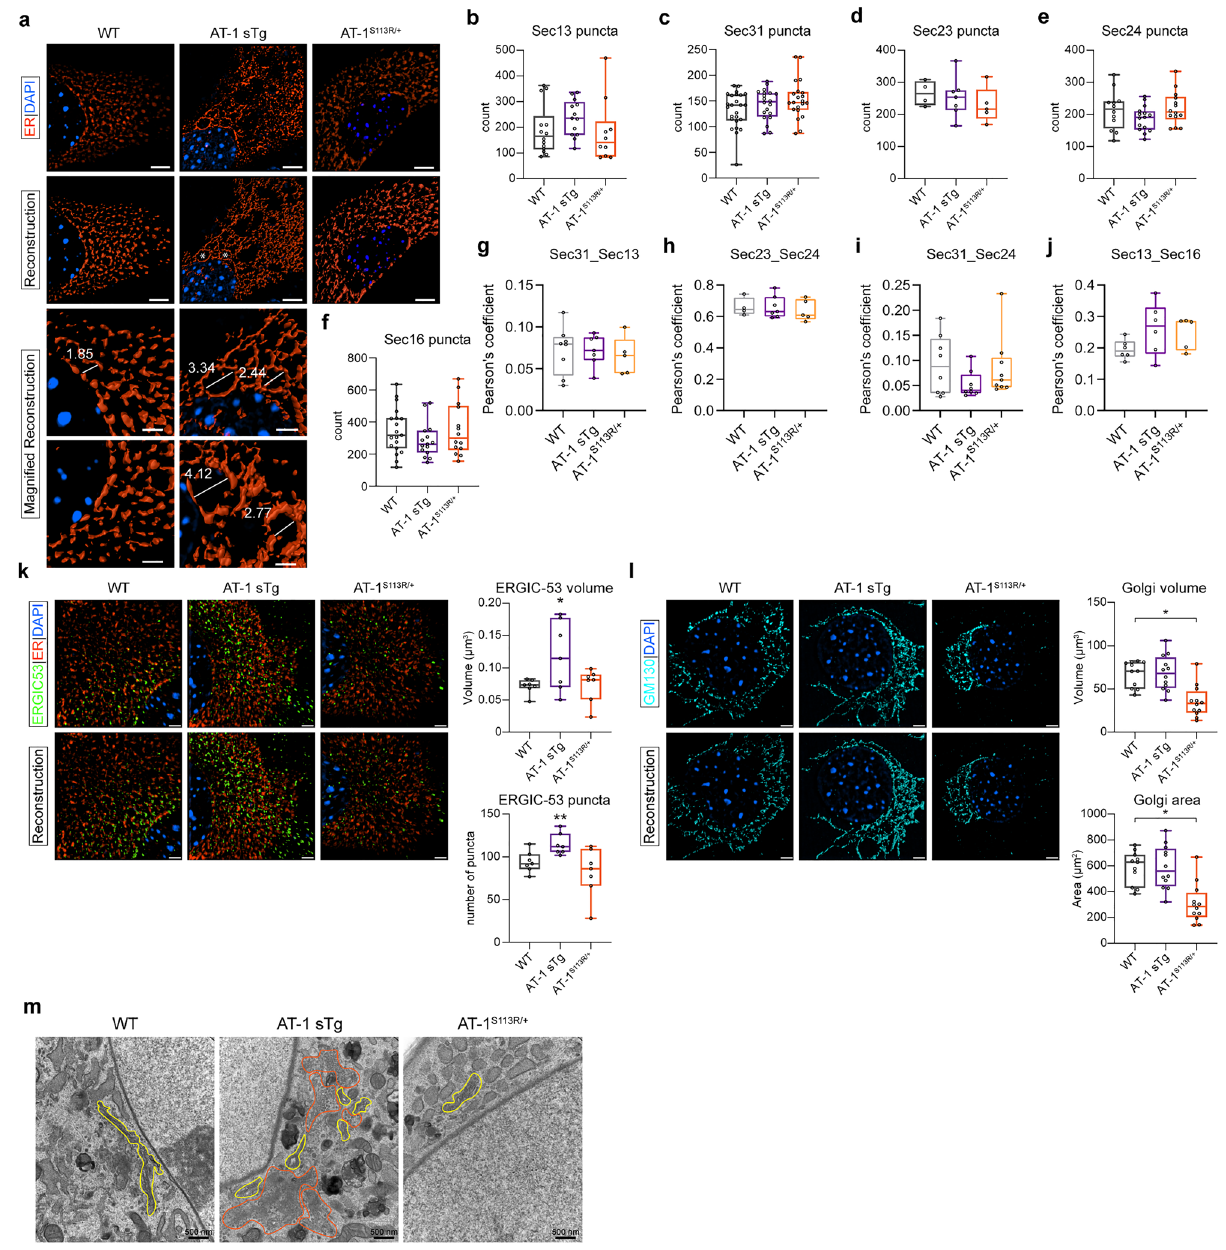
Figure 2. Morphological reorganization of ER, ERGIC and Golgi apparatus in aberrant AT-1 models. ( a ) Representative ER morphology in primary-cultured MEFs using ER3-mCherry (scale bar, 3 µm). White asterisk (*) indicates an enlarged cisternae within the perinuclear rough ER. High-magnification areas for WT and AT-1 sTg are shown (scale bar, 2 µm). ( b – f ) Quantification of puncta revealed using SIM microscopy in primary- cultured MEFs in ( b ) Sec13 puncta (n = 14 WT; n = 13 AT-1 sTg; n = 10 AT-1 S113R/+ ), ( c ) Sec31 puncta (n = 25 WT; n = 20 AT-1 sTg; n = 21 AT-1 S113R/+ ), ( d ) Sec23 puncta (n = 4 WT; n = 7 AT-1 sTg; n = 5 AT-1 S113R/+ ), ( e ) Sec24 puncta (n = 12 WT; n = 15 AT-1 sTg; n = 14 AT-1 S113R/+ ), ( f ) Sec16 puncta (n = 19 WT; n = 15 AT-1 sTg; n = 14 AT-1 S113R/+ ). ( g – j ) Pearson’s coefficient of puncta revealed using SIM microscopy in primary-cultured MEFs in ( g ) Sec31 and Sec13 puncta (n = 8 WT; n = 7 AT-1 sTg; n = 5 AT-1 S113R/+ ), ( h ) Sec23 and Sec24 puncta (n = 4 WT; n = 7 AT-1 sTg; n = 5 AT-1 S113R/+ ), ( i ) Sec31 and Sec24 puncta (n = 8 WT; n = 8 AT-1 sTg; n = 9 AT-1 S113R/+ ), ( j ) Sec13 and Sec16 puncta (n = 6 WT; n = 6 AT-1 sTg; n = 5 AT-1 S113R/+ ). ( k ) ERGIC morphology in primary-cultured MEFs using ERGIC-53 antibody (scale bar, 3 µm) and quantified using Imaris reconstruction of volume and number of puncta (n = 7 WT; n = 7 AT-1 sTg; n = 7 AT-1 S113R/+ ). ( l ) Golgi apparatus morphology in primary-cultured MEFs using GM130 antibody (scale bar, 3 µm) and quantified using Imaris reconstruction of volume and area (n = 11 WT; n = 12 AT-1 sTg; n = 12 AT-1 S113R/+ ). ( m ) Representative electron microscopy of MEFs from WT, AT-1 sTg, and AT-1 S113R/+ . Yellow outlines Golgi structures and orange outlines disorganized secretory structures and vesicles. (scale bar, 500 nm). MEFs from multiple cells from 3 biologically independent animals for each genotype for ( b – l ). One-way ANOVA. *P < 0.05; **P <